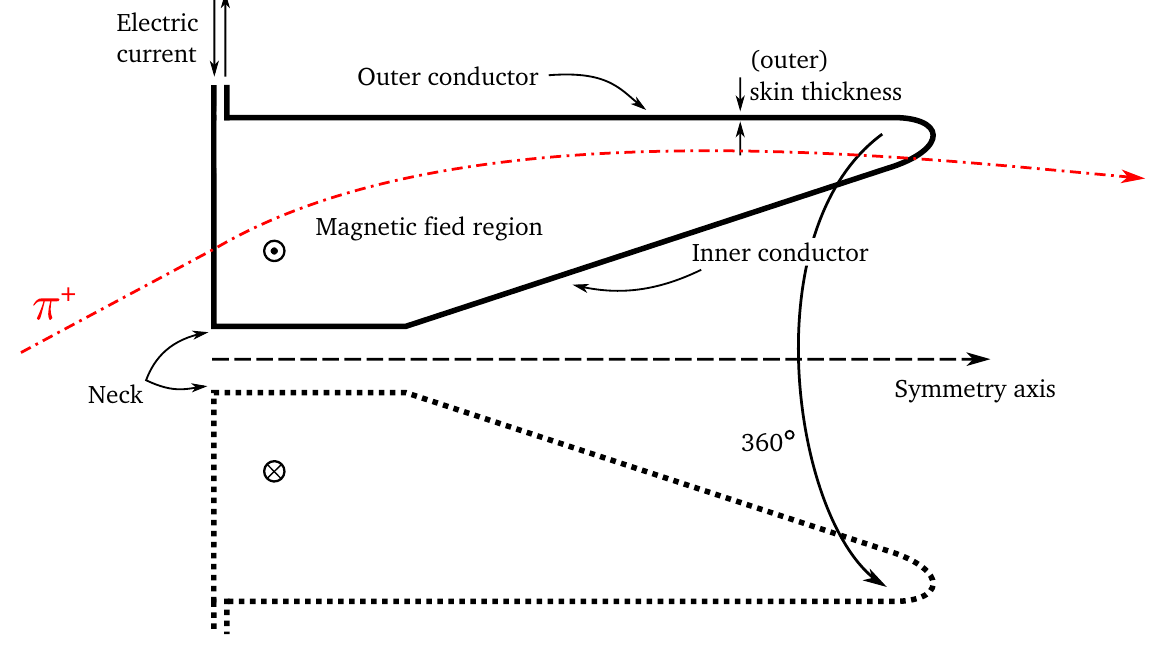
Figure 6. Schematic view of a magnetic horn: the device is axially symmetric and focuses particles of a given sign in both the transverse dimensions. The symmetry axis is also the target and beam